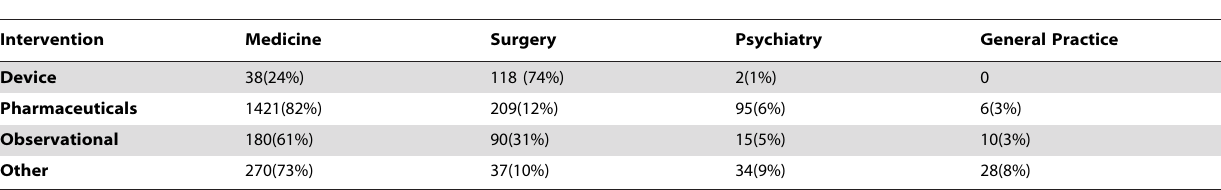
Table 1. Distribution of intervention across